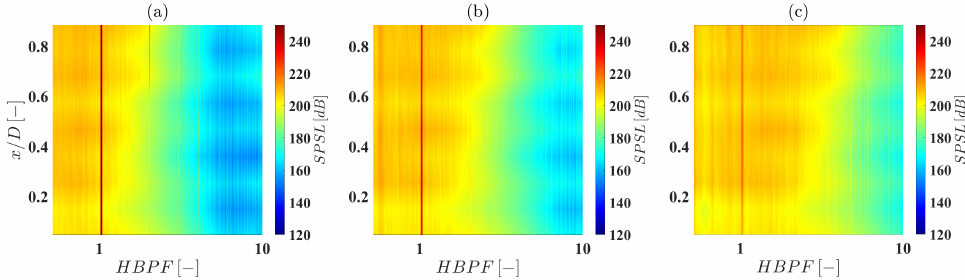
Figure 7. Contour map of the sound pressure spectrum level of the near-field pressure signals along the axial distance for each operational condition. ( a ) Propulsive configuration. ( b ) Transitional configuration. ( c ) Regenerative condition.